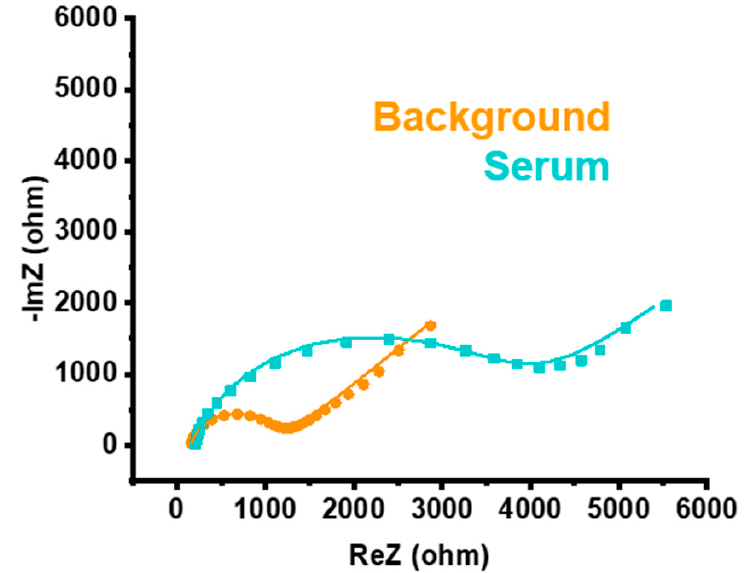
Figure 5. EIS (Nyquist plots) recorded with the immunosensor in a real serum of an infected per-